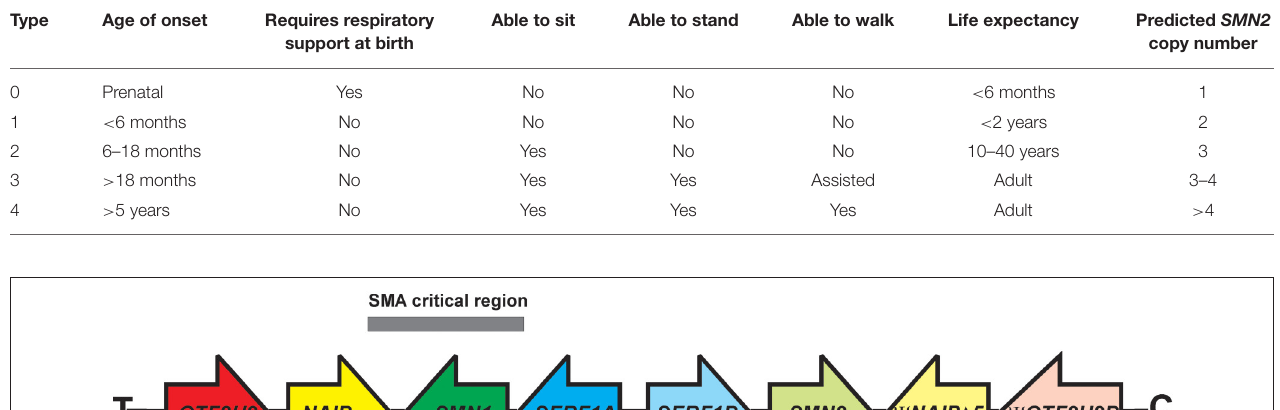
TABLE 1 | Clinical classification of spinal muscular atrophy (SMA).